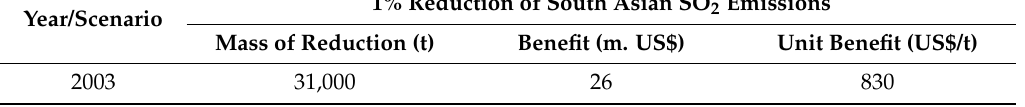
Table 4. Effect of 1% reduction in regional SO 2 emissions in term of emissions mass, GDP benefit and unit GDP